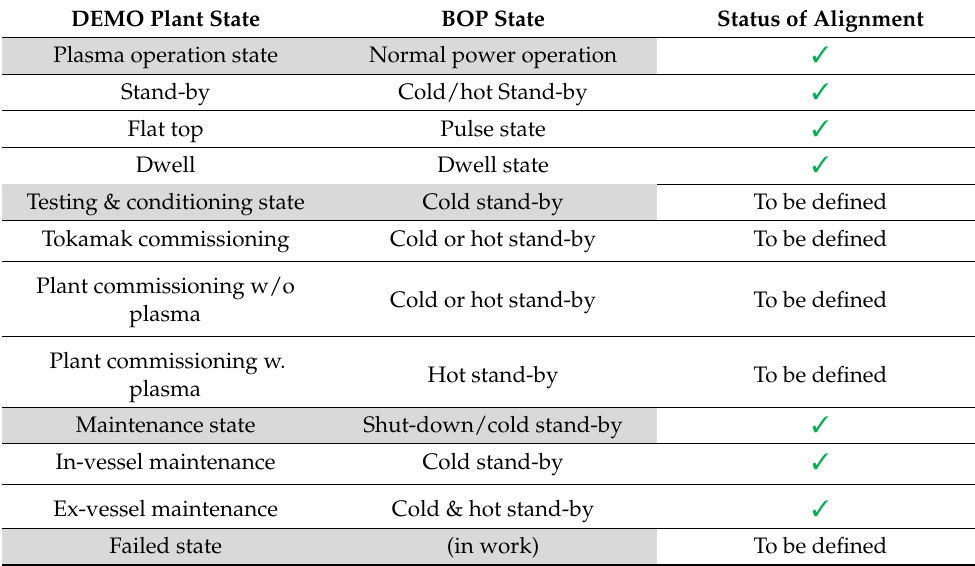
Table 2. Alignment between DEMO and BOP